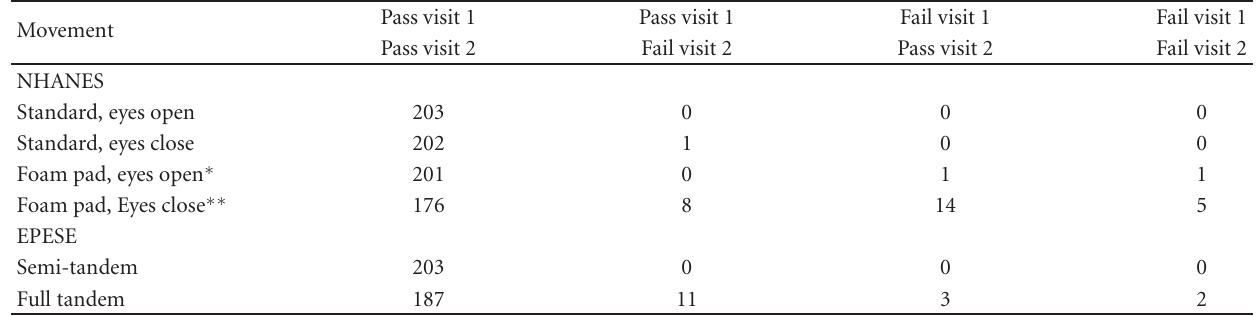
Table 4: NHANES and EPESE balance test results at visit 1 and visit 2.